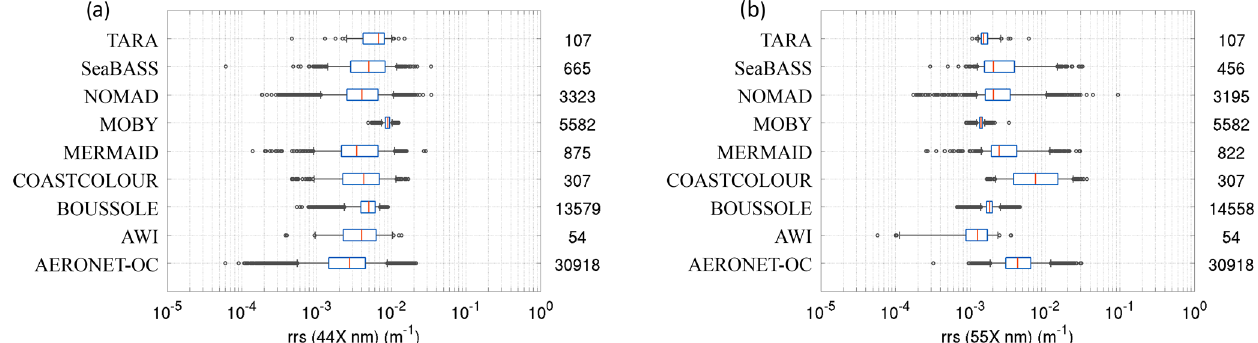
Figure 2. The distribution of (a) rrs at 44 X nm and (b) rrs at 55 X nm. Data were first searched for at 445 and 555nm and then with a search window of up to 8nm to include data at 547nm. The black boxes delimit the percentiles 0.25 and 0.75 of the data and the black horizontal lines show the extension of up to percentiles 0.05 and 0.95. The red line represents the median value and the black circles the values below (and above) the percentile 0.05 (0.95). The number of measurements of each dataset is reported on the right axis of the graph.